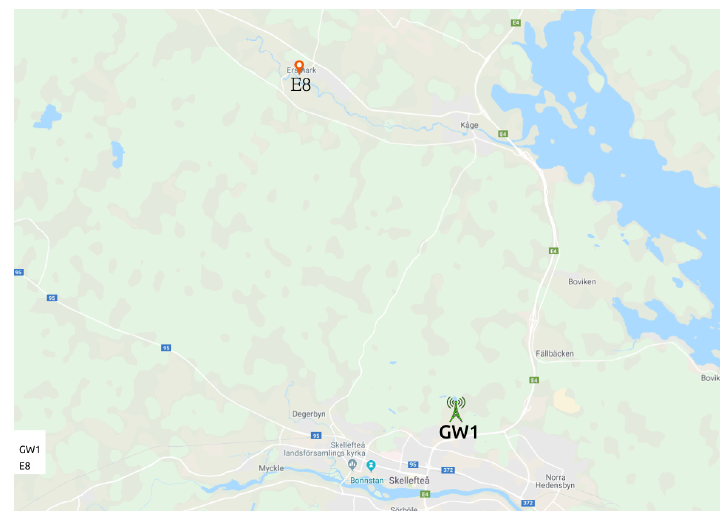
Figure 6. S2—gateway and sensor positioning. Map layer from Google Maps [41].